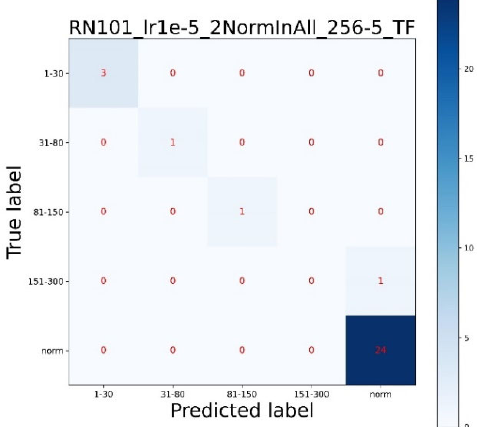
Figure 12. ISC fault classification prediction results with multiple machine learning models for experimental battery data.